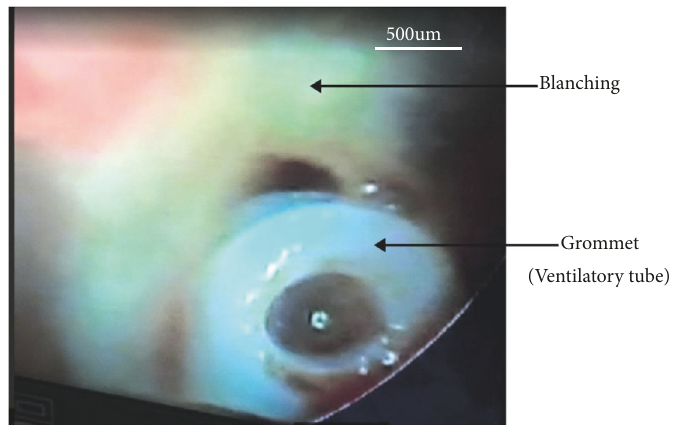
Figure 4: Shows grommet in